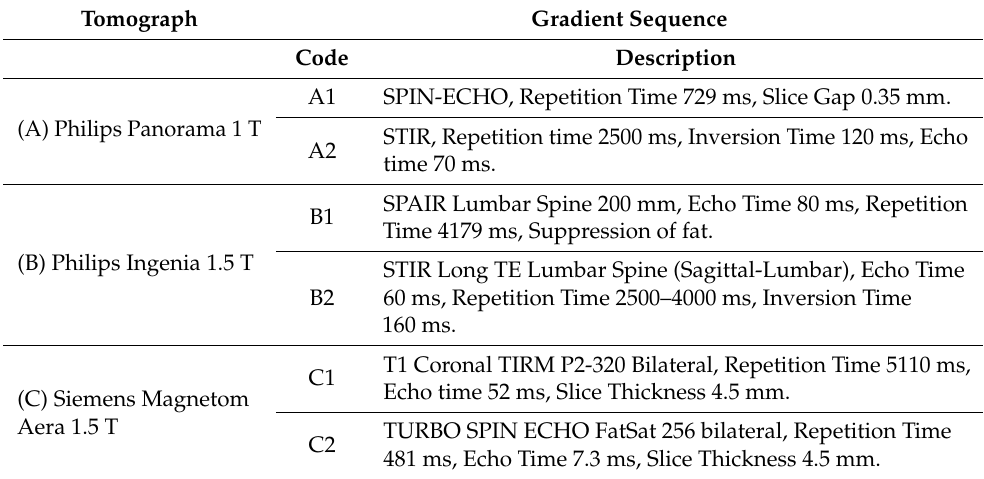
Table 3. Tomographs and GMF diagnostic sequences analysed; the “Code” column shows the reference with which the sequences are indicated in the result tables.